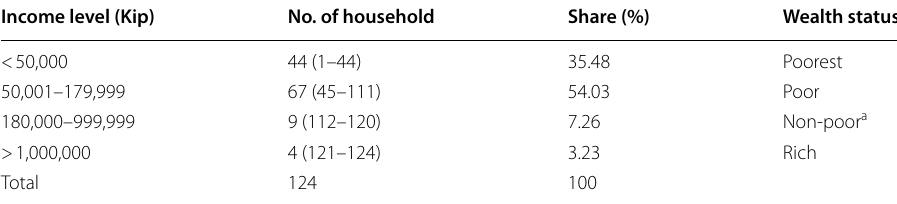
Table 4 Household income level in the targeted village (2016). Source: Field survey data, March 8,